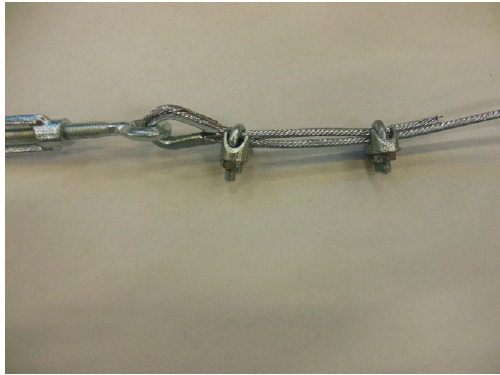
Figure 28. Specimen 3: Flemish eye closed by 1 clip.